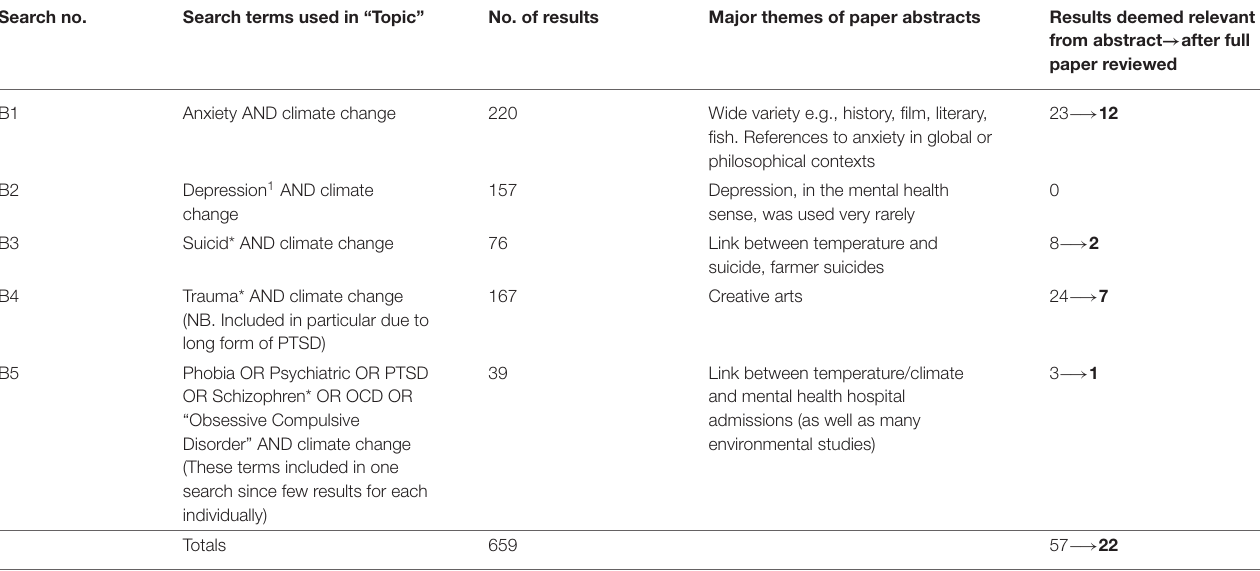
TABLE 2 | Search B results. Each search also excluded papers referencing “mental health” (since those results were already found in Search A), and the mental health search terms in earlier B searches. Search